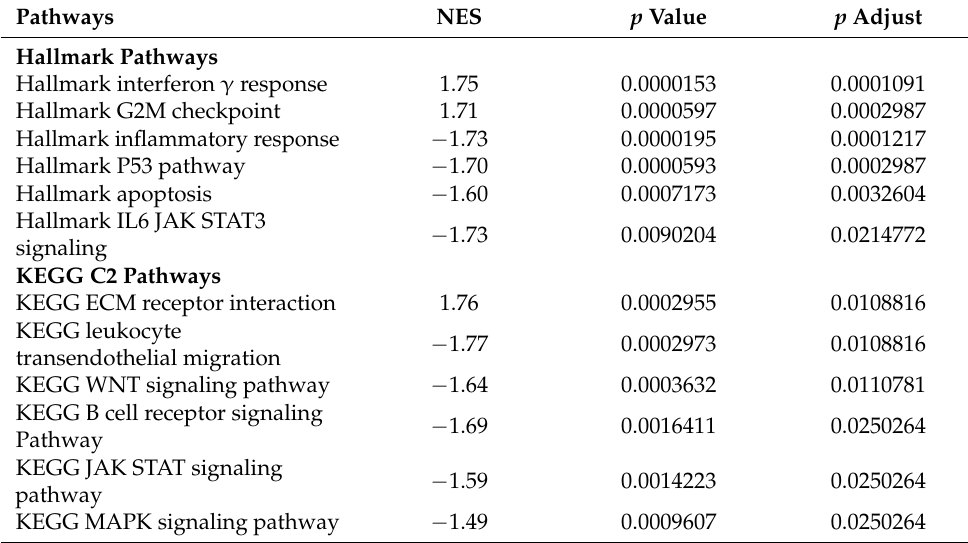
Table 3. The gene-set enrichment analysis (GSEA) of